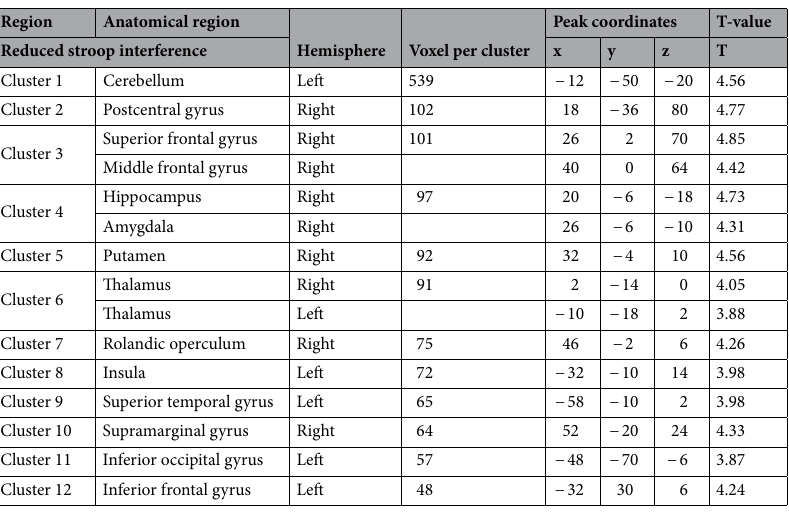
Table 2. Clusterwise statistics of the analysis of covariance of the individual stroop score with the FUN > TYP contrast. All reported regions were corrected for multiple comparisons on a cluster threshold of p < 0.05, voxel threshold p = 0.001, k = 47 voxel. Coordinates are reported in MNI space.